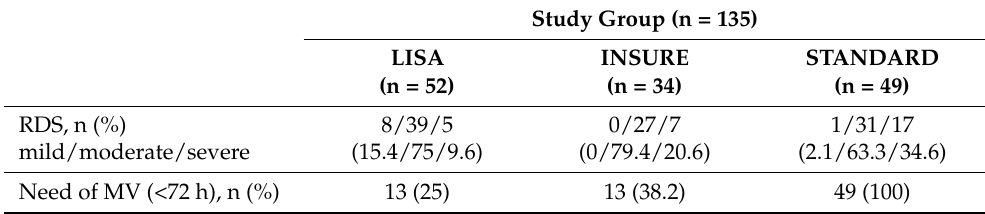
Table 3. Respiratory distress syndrome and need of MV depending on the method of administration of the